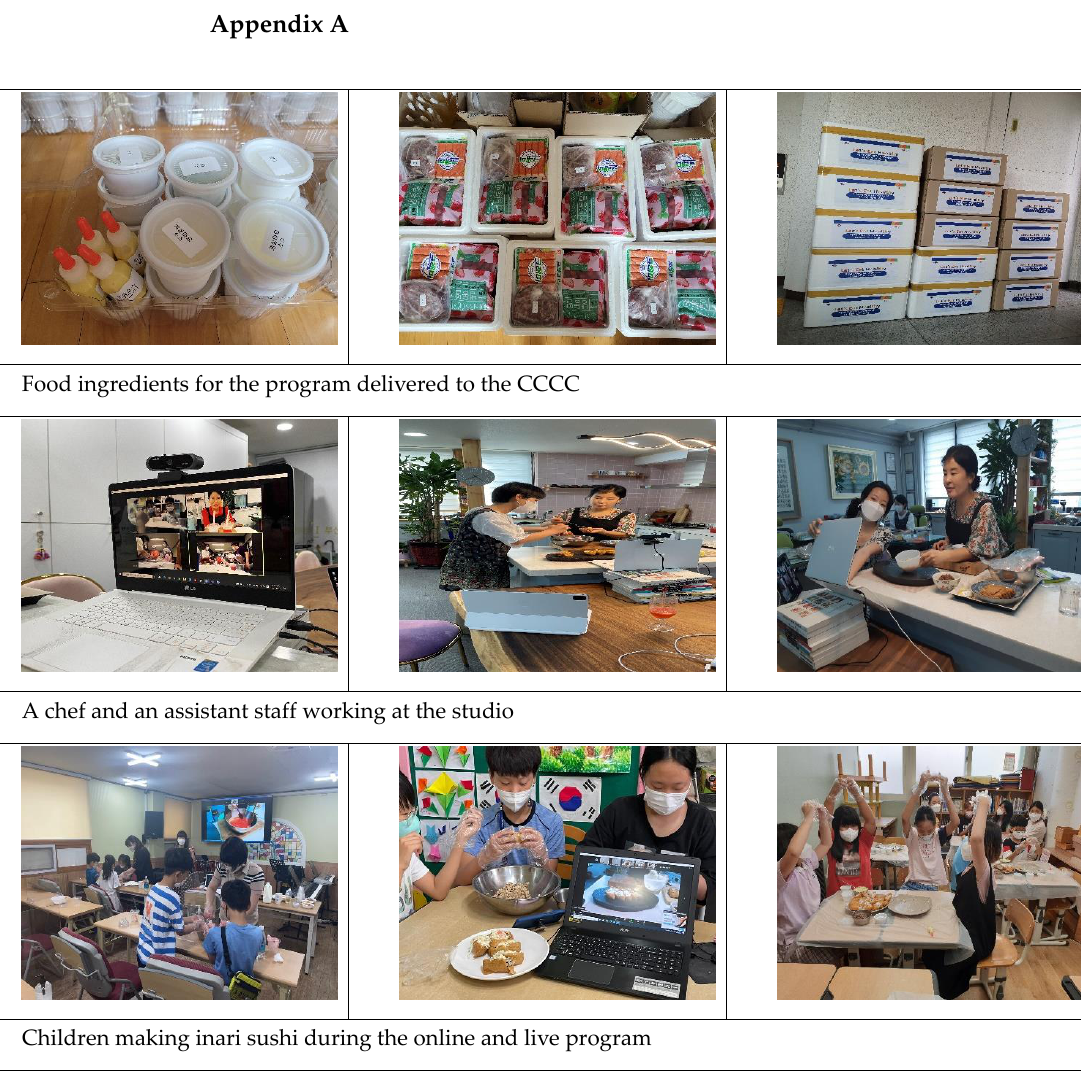
Figure A1. Details of the Interactive Live & Online Cooking